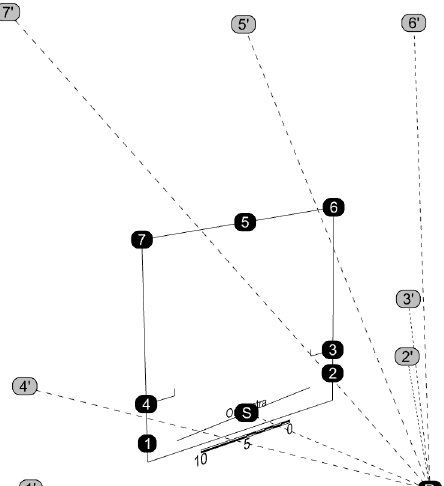
Figure 1. Skeletal reflections procedure, graphical explanation. The source position is named S, and the receiver is R. The numbers in black dots indicate the sound reflection position, grey dots indicate image sources positions. The procedure and graphs were produced using a custom script in Grasshopper for Rhino3d.